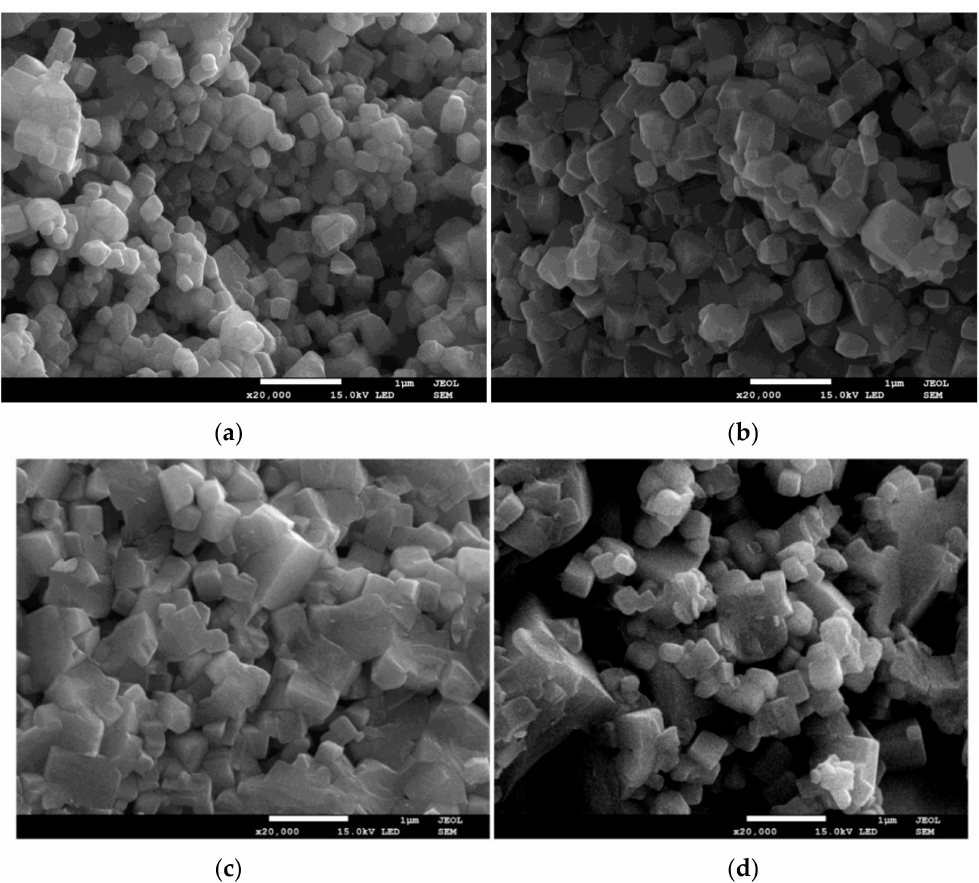
Figure 4. SEM micrographs of ceramics obtained from 25 h ( a ), 50 h ( b ), 75 h ( c ), and 100 h ( d ) milled